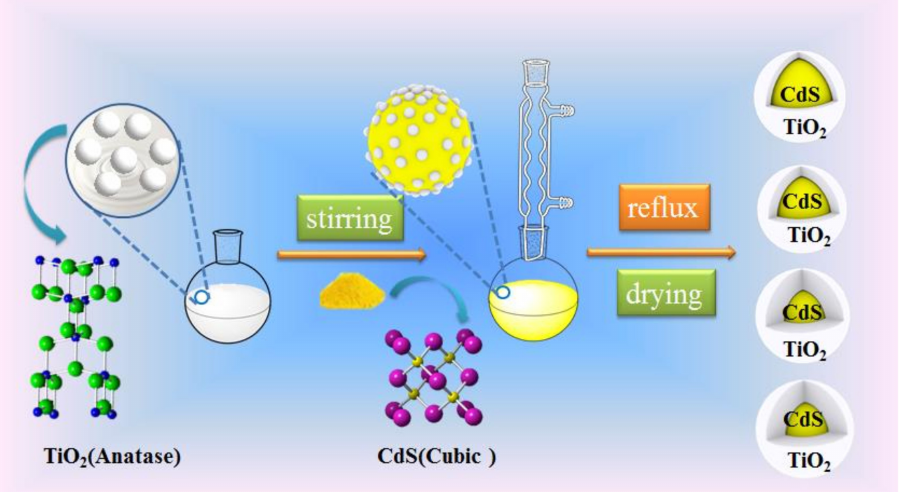
Scheme 1. The preparation mechanism diagram of different shell thickness core-shell CdS@TiO